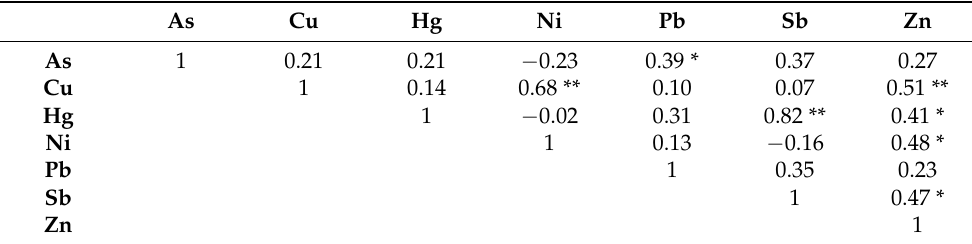
Table 4. Pearson correlation matrix for the PTEs in the soil samples. As Cu Hg Ni Pb Sb Zn As 1 0.21 0.21 − 0.23 0.39 * 0.37 0.27 Cu 1 0.14 0.68 ** Hg 1 − 0.02 Ni Pb Sb 1 0.47 * Zn 1 * The correlation is significant at the 0.05 level (two-tailed). ** The correlation is significant at the 0.01 level